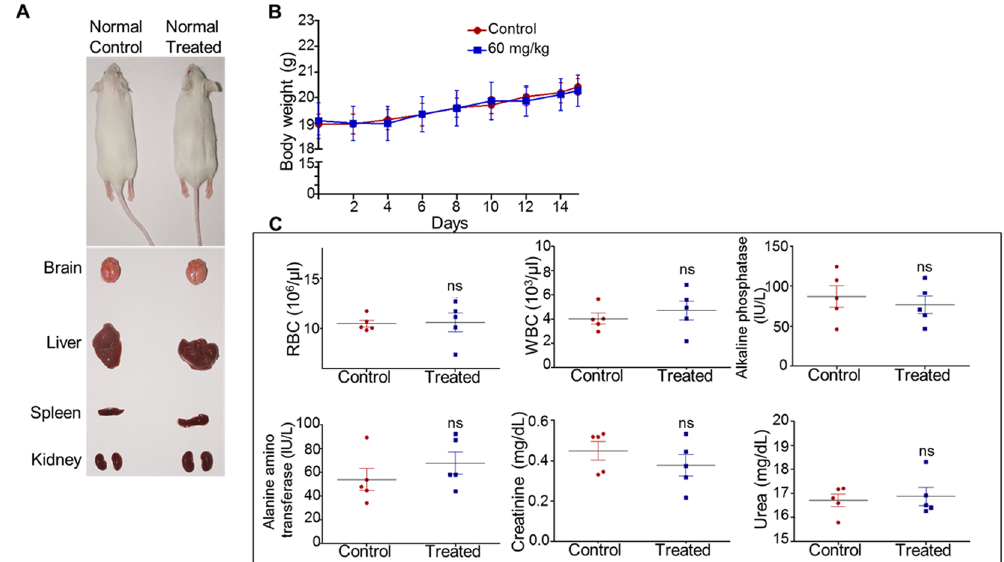
Figure 9. Evaluation of side effect of 5g-treament in mice. Mice were treated with 5g (60 mg/kg; 14 doses, continuously; one dose/day) and examined for potential side effects. ( A ) On 15 th day of treatment, control and 5g administered mice were sacrificed and tested for gross changes in organs like brain, liver, spleen and kidney, and images were presented. ( B ) Impact of 5g on body weight in normal mice. The body weight was measured and presented as graph with error bars indicated. ( C ) On 15 th day, blood was collected from control and treated mice and evaluated for blood parameters (RBC and WBC count), liver function tests (alkaline phosphatase and alanine amino transferase assay) and kidney function tests (creatinine and urea). Data is presented with error bars (n = 5). Statistical significance was calculated using student t-test and significance was shown if the p-value was equal to or less than 0.05 ( * 0.05, ** 0.005, ***